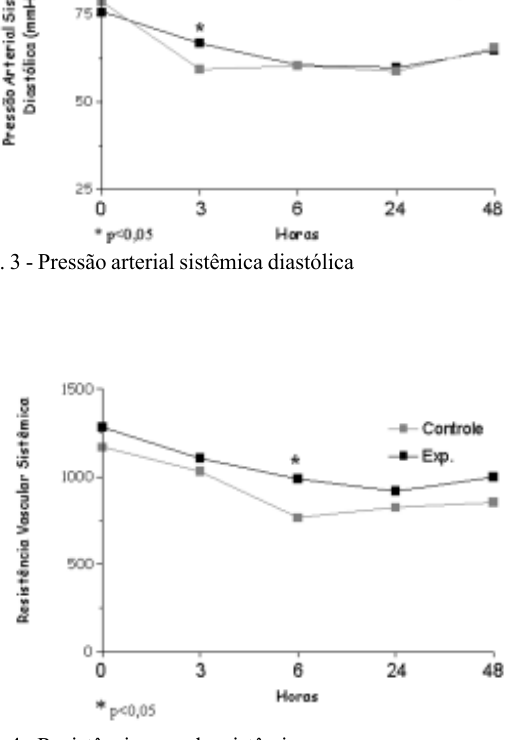
Fig. 4 - Resistência vascular